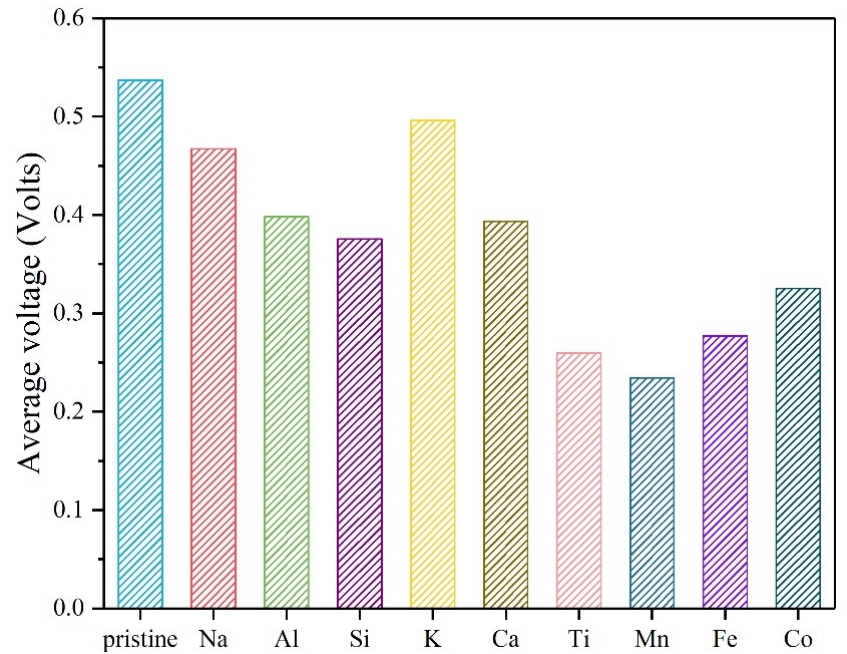
Figure 4. The average voltages of pristine and various doped Mg 2 NiH 4 electrode materials.